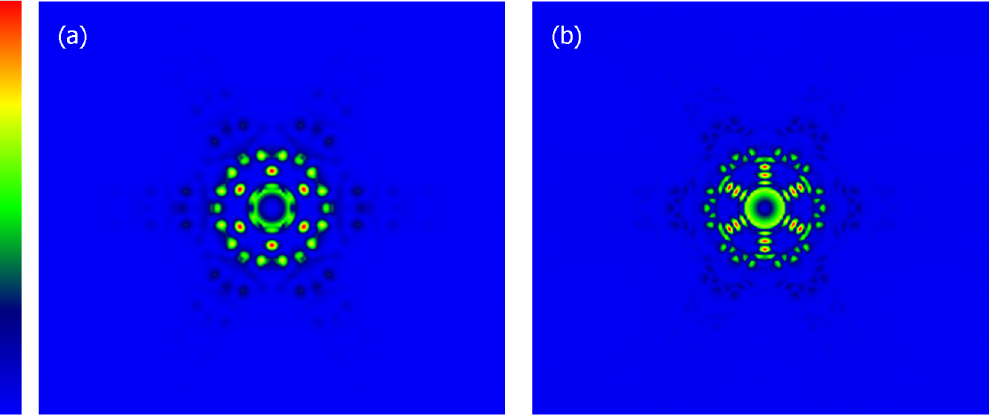
FIG. 5. (a) Longitudinal and (b) radial Poynting flux of the TM defect mode in the PBG fiber. The fiber region is the same as in Fig. 3, but the hole boundaries are excluded to clearly show the extended flux